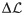
Flickering rate is homogenous within each conflicting period.A. Distribution of the path-integrator realignment times in a simulated session (right) and inferred from the recorded data (left). B. Mean Frequency of Flickers (MFF) during the conflicting phase, binned over 8 theta bins (∼ 1 second) intervals. MFF is constant during the conflicting phase, both in the model (right) and in recordings (left). Realignment times inferred from data were obtained with a Bayesian procedure (Methods); histograms show flickering frequency in each time bin t normalized with respect to the fraction of conflicting phases, out of 15 teleportation events, that survived at least up to time t. C. Convolution of the two distributions shown in panels A and B, i.e. the MFF computed on the full test session, shows an apparent exponential decay both in the model (right) and in data (left, similar to the analysis shown in [27]). D. Map decoder output ΔL and inferred PI-realignment times for the experimental test session; 3 out of 15 teleportations are shown. Light switches are marked with red lines, inferred PI-realignment times are marked with green lines. Identified conflicting periods are shaded. Simulated data were obtained with the same model parameters as in Fig 3.